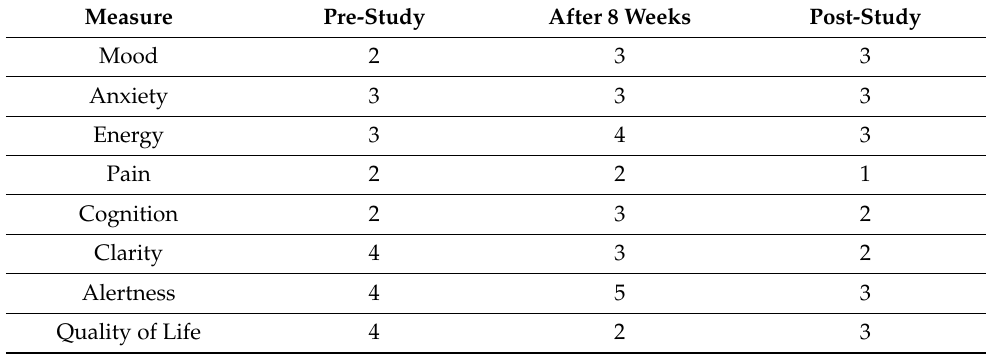
Table 1. Case One: Likert Scale Ratings.